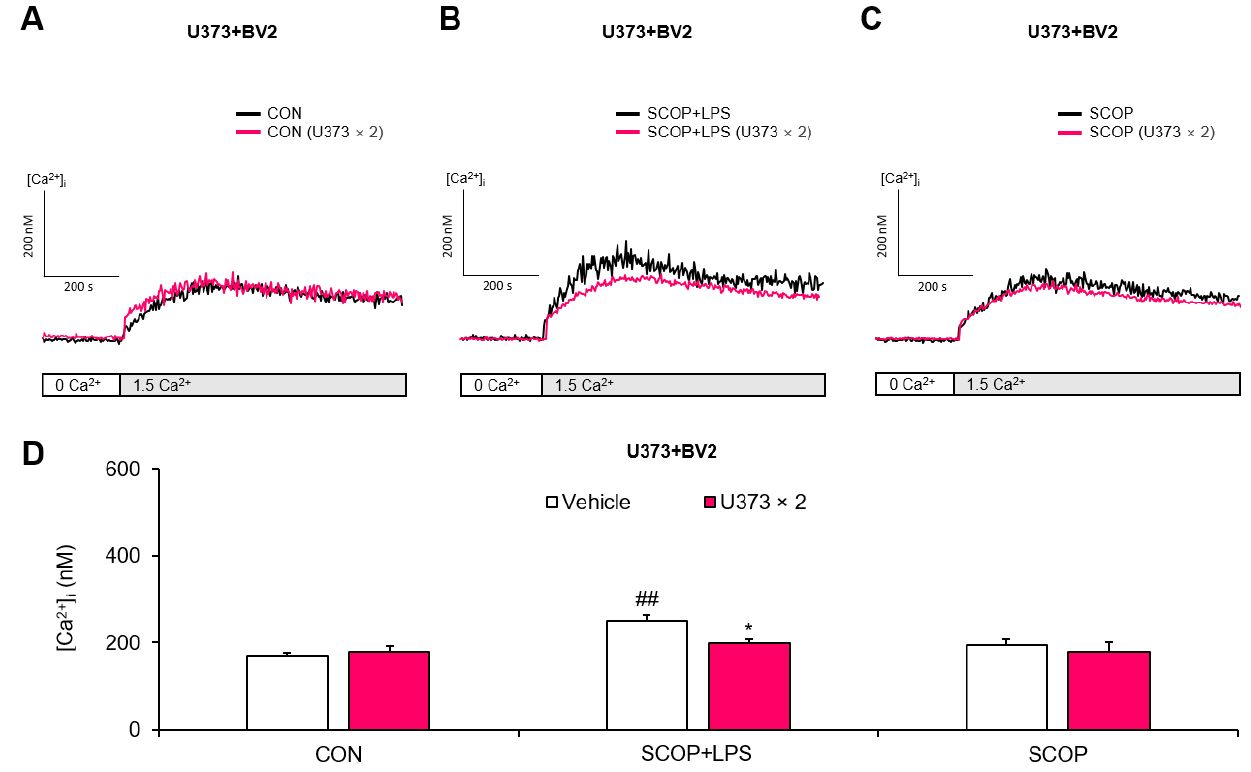
Figure 4. Effects of doubling the number of U373 cells on store-operated Ca 2+ entry (SOCE) in scopolamine (SCOP)-pretreated U373 + BV2 mixed cells exposed to LPS. Representative traces of the ( A ) control (CON), ( B ) SCOP+LPS, and ( C ) SCOP groups. ( D ) Summary data showing the peak [Ca 2+ ] i observed after the addition of 1.5 mM Ca 2+ . Data are reported as means ± SEM ( n = 5–7; ## p < 0.01 vs. the respective CON group; * p < 0.05 vs. the respective vehicle group).